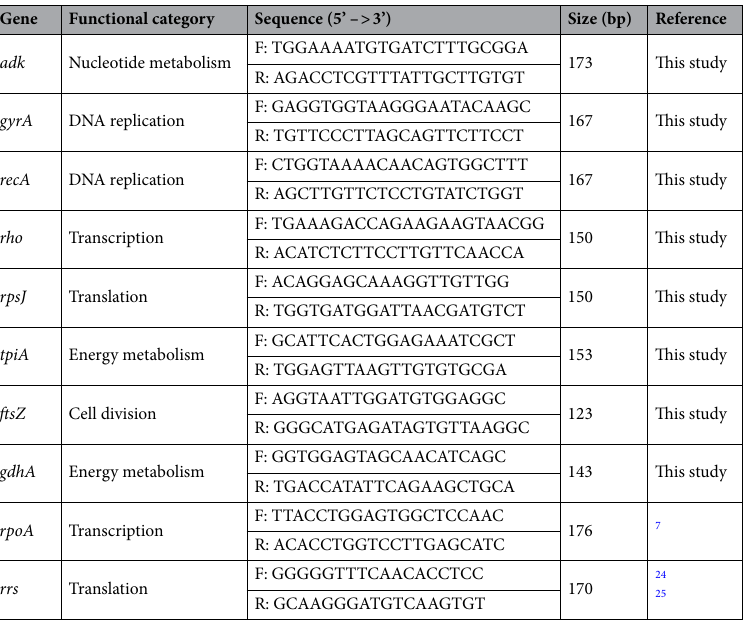
Table 1. Candidate reference genes, functional groups, primer sequences, and expected amplicon sizes. Fragment sizes are based on alignment to C. perfringens ATCC